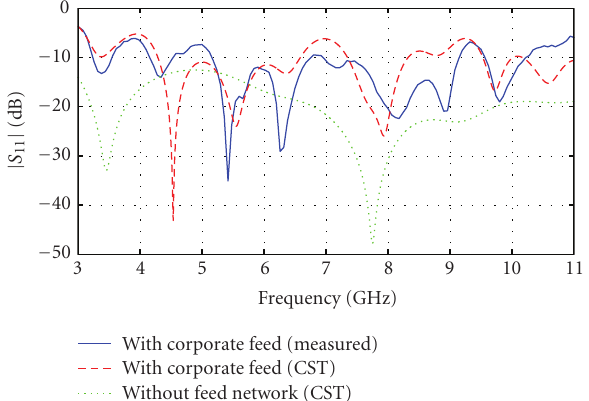
Figure 22: Simulated and measured | S 11 | curves for the four- element UWB array prototype with corporate feed ( d = 28 mm) compared to the array without feed